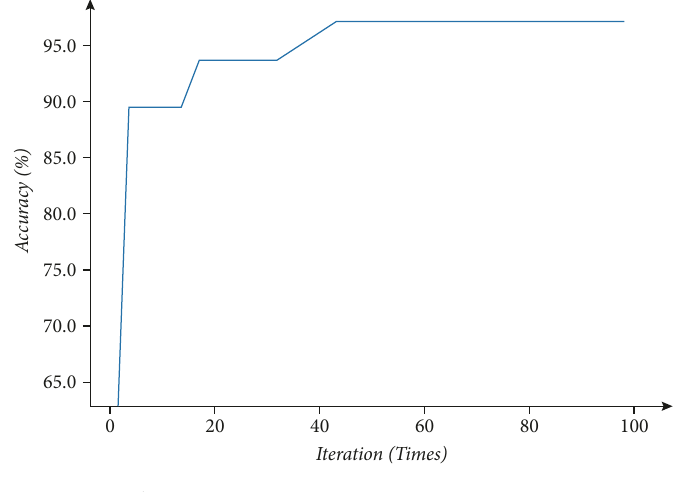
Figure 13: Optimization of SVM by genetic algorithm.